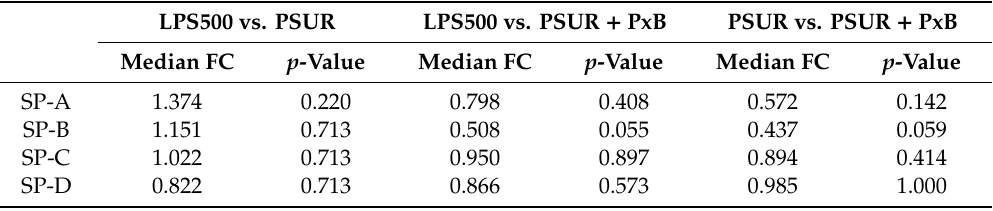
Table 2. Median fold change (FC) and p -values for SP gene expression after treatment with PSUR alone or in combination with PxB.